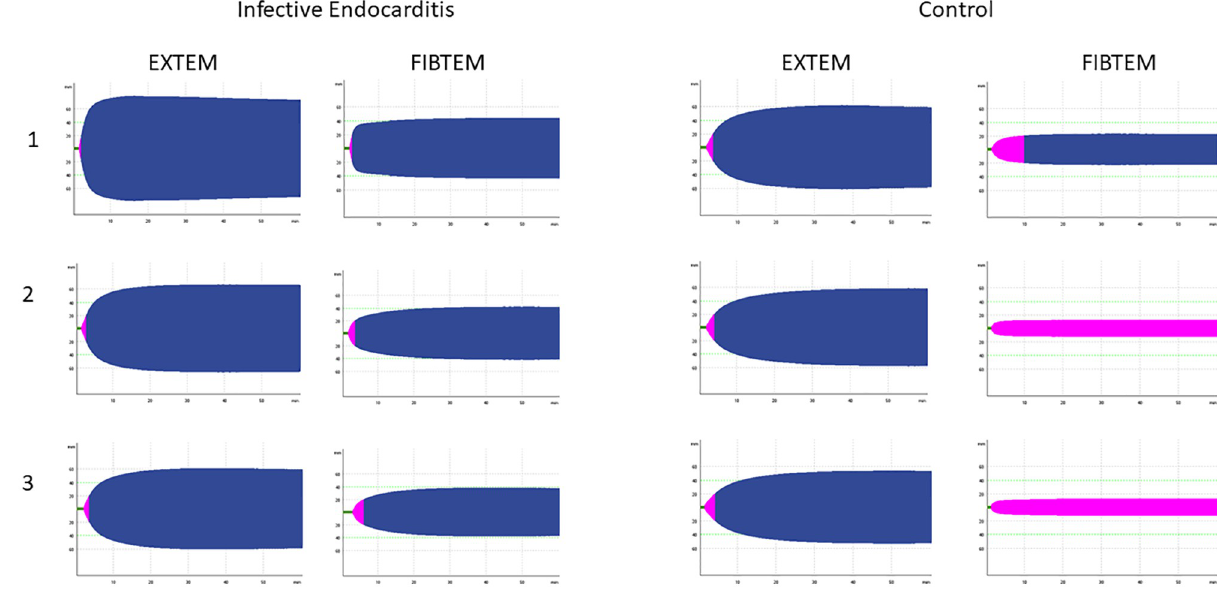
Fig 2. Exemplary TEMograms of ROTEM channels EXTEM and FIBTEM. TEMograms shown from patients with and without infective endocarditis at three time points: 1. after induction of anesthesia, 2. directly after removal of the aortic cross-clamp before protamine administration, and 3. at the end of